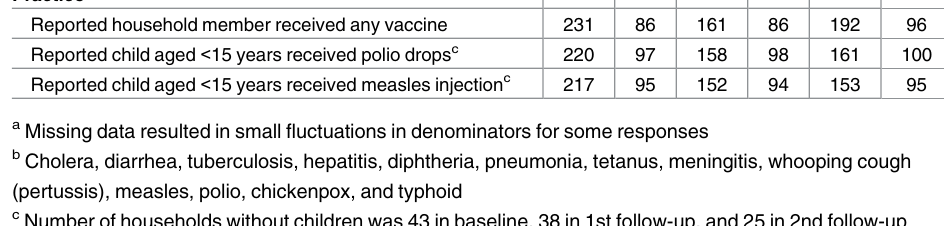
Table 4. Knowledge, attitudes and practices about vaccination in surveysconducted 1 month before (baseline), and 3 and 12 months after (first and second follow-up) an oral cholera vaccination cam- paign, Maela Camp, 2013. Knowledge and attitude Baseline 1 st follow-up 2 nd follow-up (n = 271) a (n = 187) a (n = 199) a No. % No. % No. % Knew (cid:21) 2 diseases prevented by vaccines b 135 50 98 52 136 68 Knew measles prevented by vaccine 115 42 82 44 100 50 Knew polio prevented by vaccine 101 37 65 35 97 49 Knew cholera prevented by vaccine 31 11 56 30 77 39 Heard of cholera vaccine 107 39 176 94 185 93 Concerns about household adults receiving vaccines 11 4 4 2 3 2 Concerns about household children receiving vaccines c 17 7 8 5 2 1 Practice Reported household member received any vaccine 231 86 161 86 192 96 Reported child aged < 15 years received polio drops c 220 97 158 98 161 100 Reported child aged < 15 years received measles injection c 217 95 152 94 153 95 a Missing data resulted in small fluctuations in denominators for some responses b Cholera, diarrhea, tuberculosis, hepatitis, diphtheria, pneumonia, tetanus, meningitis, whooping cough (pertussis), measles, polio, chickenpox, and typhoid c Number of householdswithout children was 43 in baseline, 38 in 1st follow-up, and 25 in 2nd